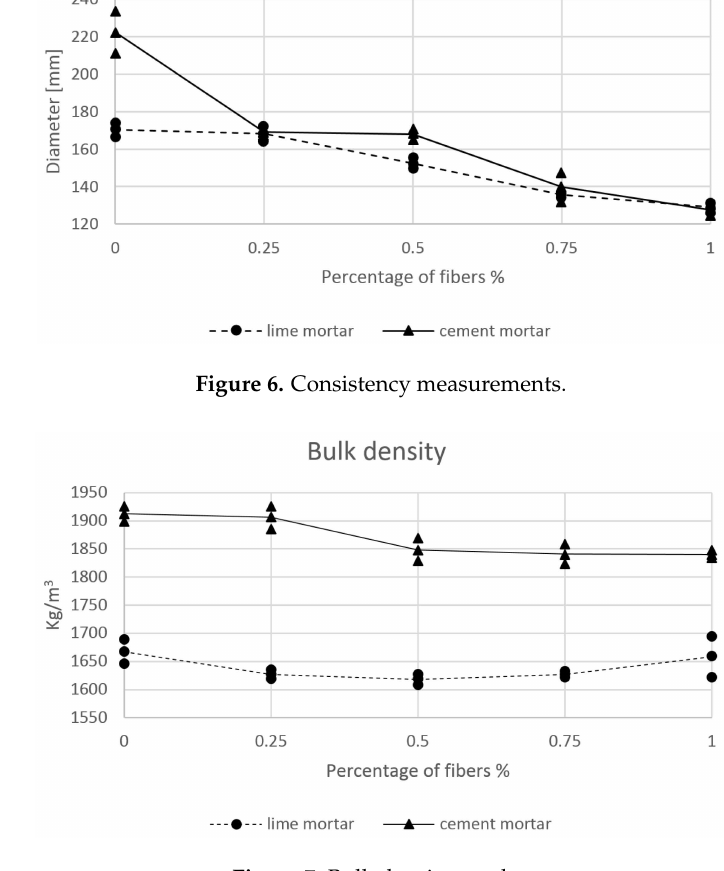
Figure 7. Bulk density results.